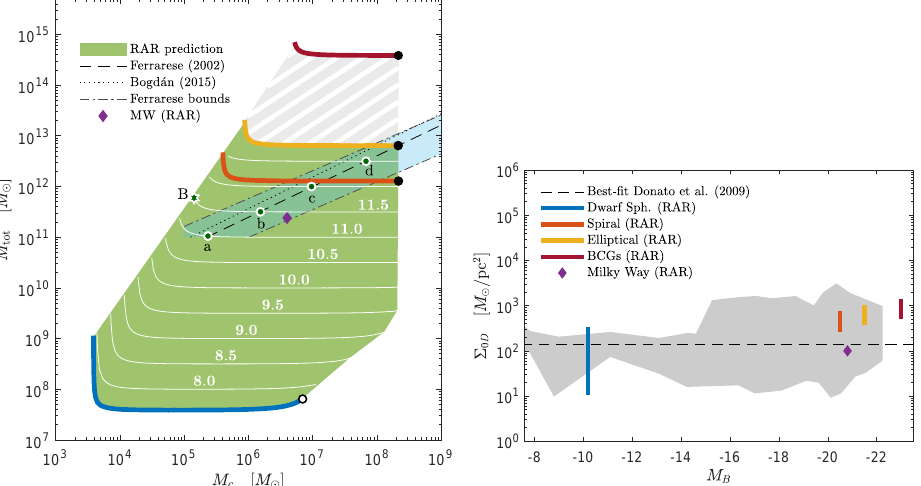
Figure 9. ( Left ): Theoretical M c − M tot relation within three − parametric RAR model (for mc 2 = 48 keV). The colored lines read for each galaxy type in correspondence with the astro- physical RAR solutions in Figure 8. The green area covers the RAR predictions for a given halo mass in the range M h ≈ 10 7 –10 12 M (cid:12) and fulfilling Σ 0 D ∝ ρ pl r h = 140 M (cid:12) pc − 2 , as inferred from the Donato relation (see right panel). The white lines show a set of families with given halo mass M h (and labeled by the M tot value in the horizontal regime). The results show that the RAR model agrees with the different M BH − M tot relations, as considered in the literature and shown in the blueish stripe. The filled black dots correspond to the critical core mass M crit c , and the empty black dot indicates the limiting maximum core mass M max c for dwarfs. ( Right ): Surface DM density (or Donato) relation as predicted by the RAR model (see vertical colored lines) for each galactic structure in correspondence with the astrophysical solutions (i.e., blue − shaded regions in Figure 8). The dashed horizontal line represents the universal relation from the best fit of the data as found by [62]. The dark grey region indicates the delimited area by the 3 − σ error bars of all the data points. Reprinted from [33], Copyright (2019), with permission from